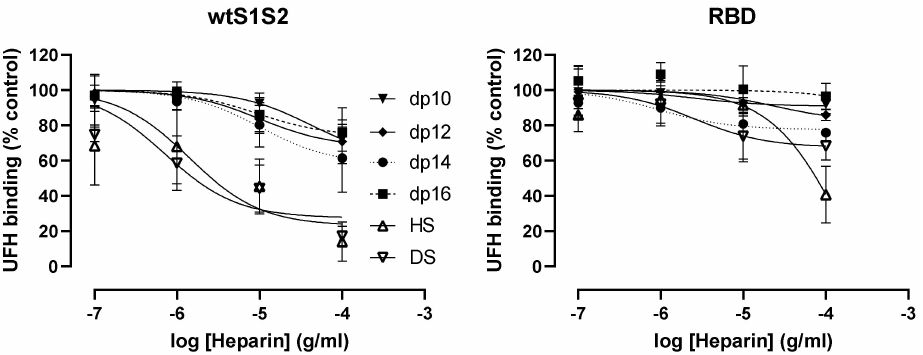
Figure 12. Dose–response curves for the inhibition of wtS1S2 and RBD binding to immobilised unfractionated heparin by selected heparins and glycosaminoglycans. Unfractionated heparin (UFH) was immobilised on 96-well plates and used to detect the binding of wtS1S2, mS1S2 and RBD in the presence of increasing concentrations of heparins of increasing chain length (dp10–16, heparan sulphate (HS) or dermatan sulphate (DS)), detected using a biotinylated anti-His6 antibody and streptavidin-HRP. Data are shown as a percentage of binding to untreated control wells and are the means ± SEM of 4 separate experiments performed in